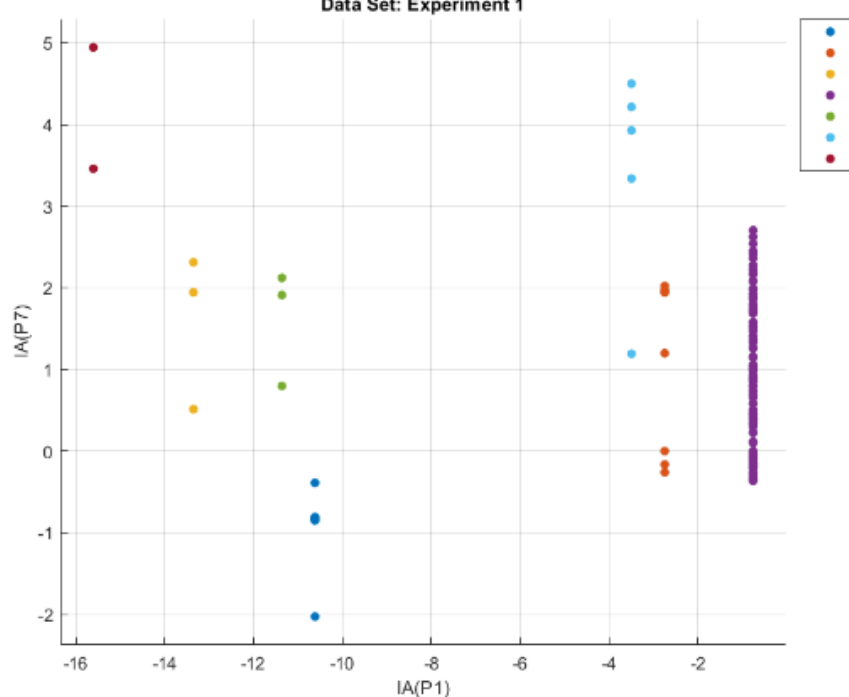
Figure 14. Data set of experiment 1.